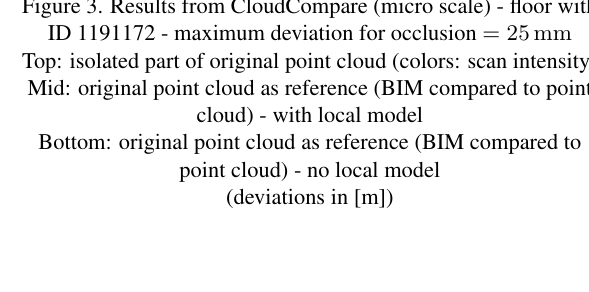
Figure 3. Results from CloudCompare (micro scale) - floor with ID 1191172 - maximum deviation for occlusion = 25 mm Top: isolated part of original point cloud (colors: scan intensity) Mid: original point cloud as reference (BIM compared to point cloud) - with local model Bottom: original point cloud as reference (BIM compared to point cloud) - no local model (deviations in